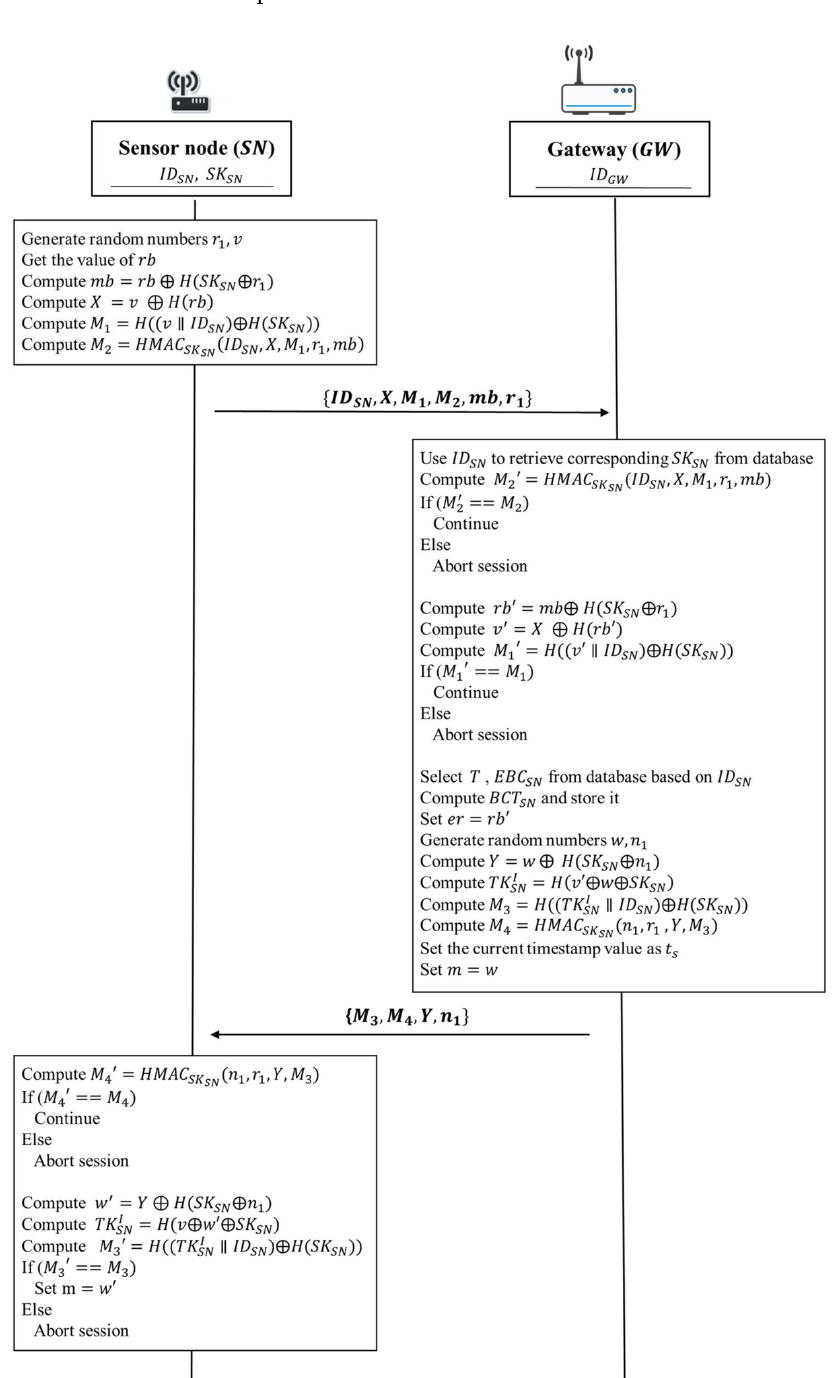
Figure 5. The static authentication phase of the proposed